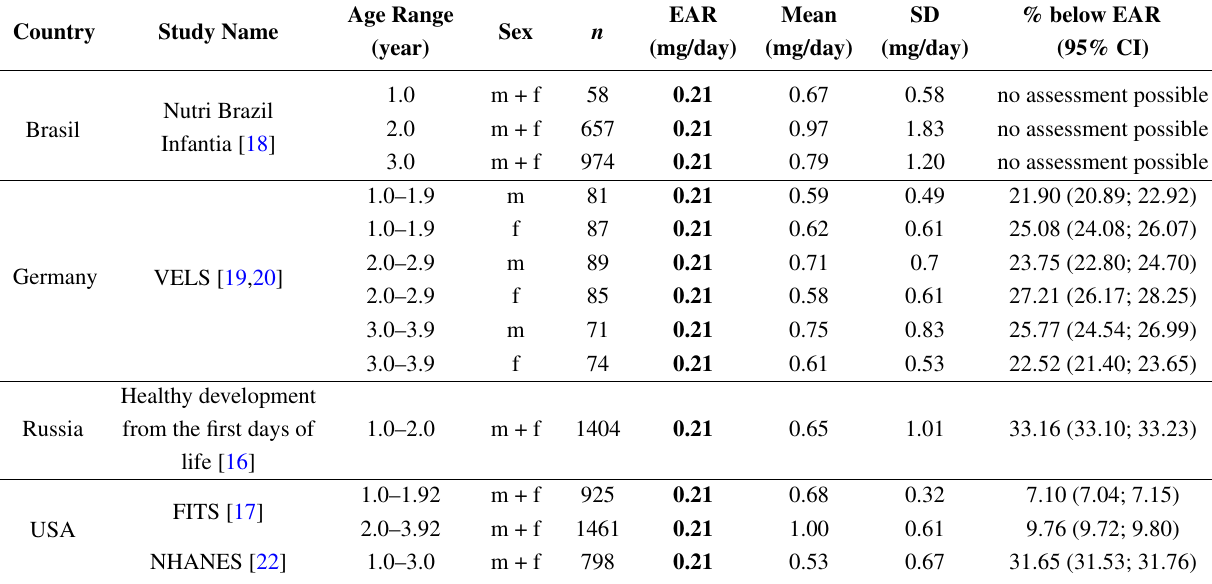
Table 3. Mean vitamin A intake (mg/day) and prevalence of inadequate intake (% below EAR) in Brazil, Germany, Russia and the United